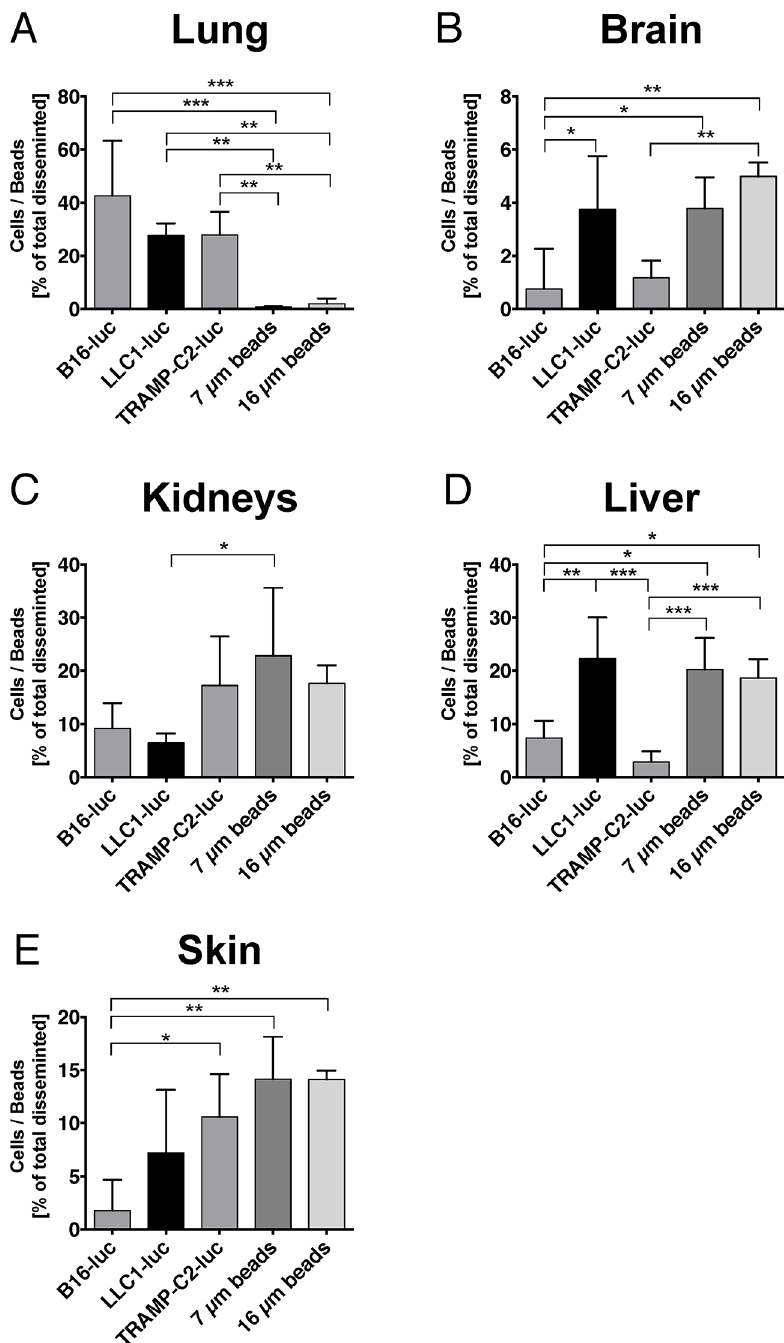
Fig 3. B16-luc, LLC1-luc, TRAMP-C2-luc and microsphere dissemination (7 and 16 μ m diameter) in soft tissues. (A) Individual lung dissemination of tumor cells varied between ~30 – 40%. In contrast, very few microbeads (independent of their size) were found in the lung. All cell types disseminated significantly higher to the lung compared to microbeads (B16-luc vs. 7 μ m beads: p < 0.0001, B16-luc vs. 16 μ m beads: p < 0.0001, LLC1-luc vs. 7 μ m beads: p = 0.0025, LLC1-luc vs. 16 μ m beads: p = 0.0039, TRAMP-C2-luc vs. 7 μ m beads: p = 0.0024, TRAMP-C2-luc vs. 16 μ m beads: p = 0.0037). (B) Tumor cell and microbeads dissemination to the brain was relatively low (~5%). LLC1-luc cells disseminated significantly higher to the brain compared to B16-luc. Cell sized (16 μ m) microbeads also disseminated significantly higher to the brain compared to B16-luc and even TRAMP-C2-luc (B16-luc vs. LLC1-luc: p = 0.0288, B16-luc vs. 7 μ m